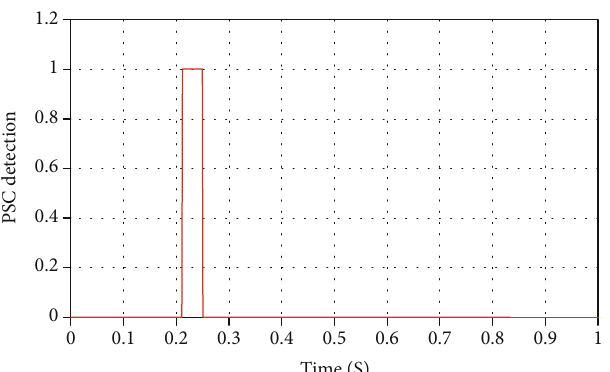
Figure 42: The PSC detection fl ag.